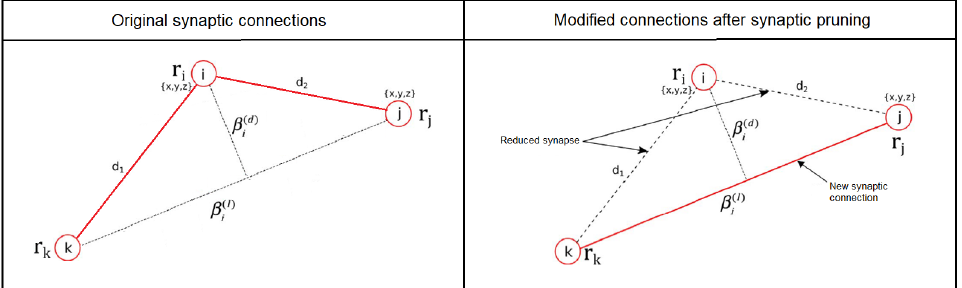
Figure 15. Reduction in the number of connections by synaptic